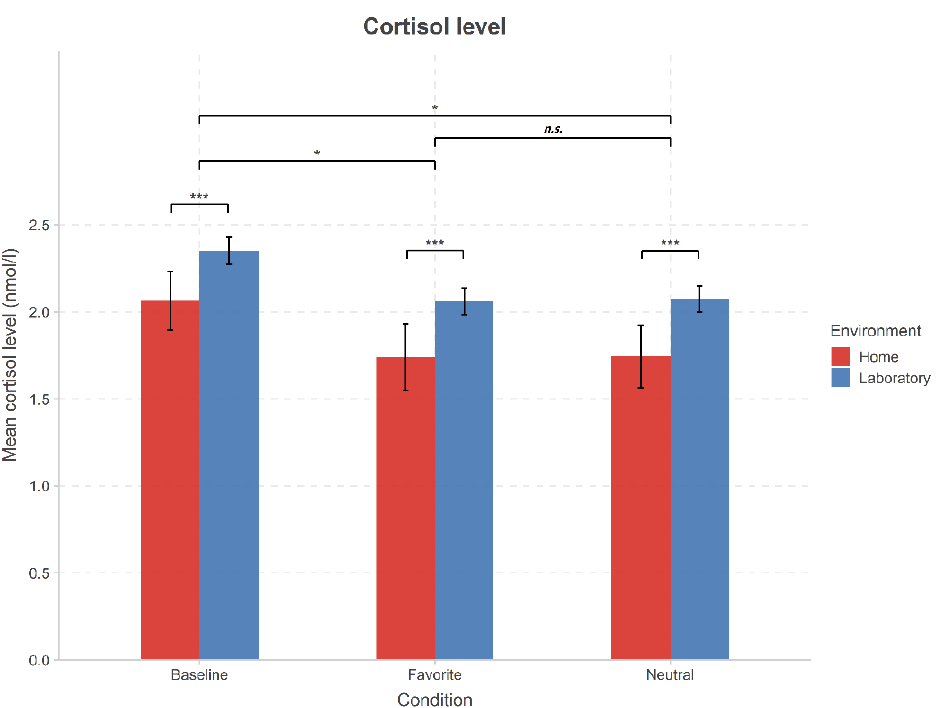
Figure 1. Cortisol levels as collected at home (red) and in the laboratory (blue) (mean and SEM). Cortisol levels were the highest before music listening (baseline) and were significantly decreased after neutral and favorite music listening. Cortisol level were lower at home than in the laboratory. There was no interaction between the listening environment and music listening. * p < 0.05, *** p < 0.001, n.s. p > 0.05.